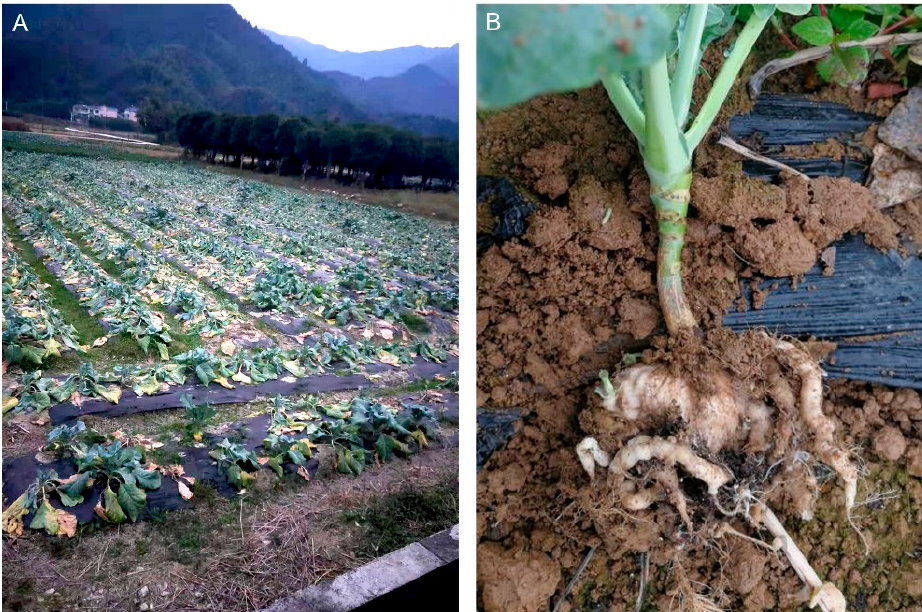
Figure 1. Cauliflower infected with clubroot [( A ) Cauliflower field heavily infested with clubroot disease, ( B ) Clubroot-infected cauliflower plant with characteristic root gall].